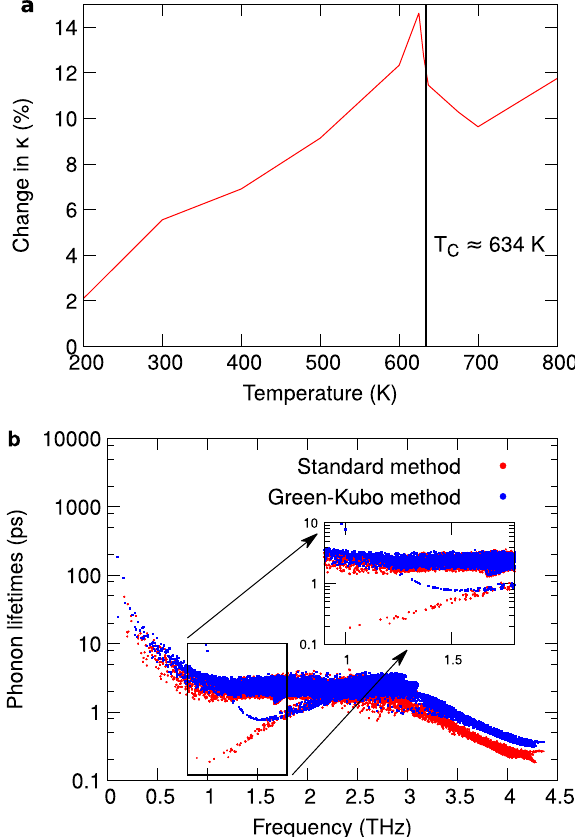
Fig. 6 Green – Kubo lattice thermal conductivity. a Difference in the calculated lattice thermal conductivity using the Green – Kubo method (Eq. (6)) and the Boltzmann transport equation. b Phonon lifetimes of GeTe (see text for explanation) in the Green – Kubo and Boltzmann transport equation approach plotted vs. TDEP frequency of phonon modes. Inset shows the region of soft phonon modes where the change is most